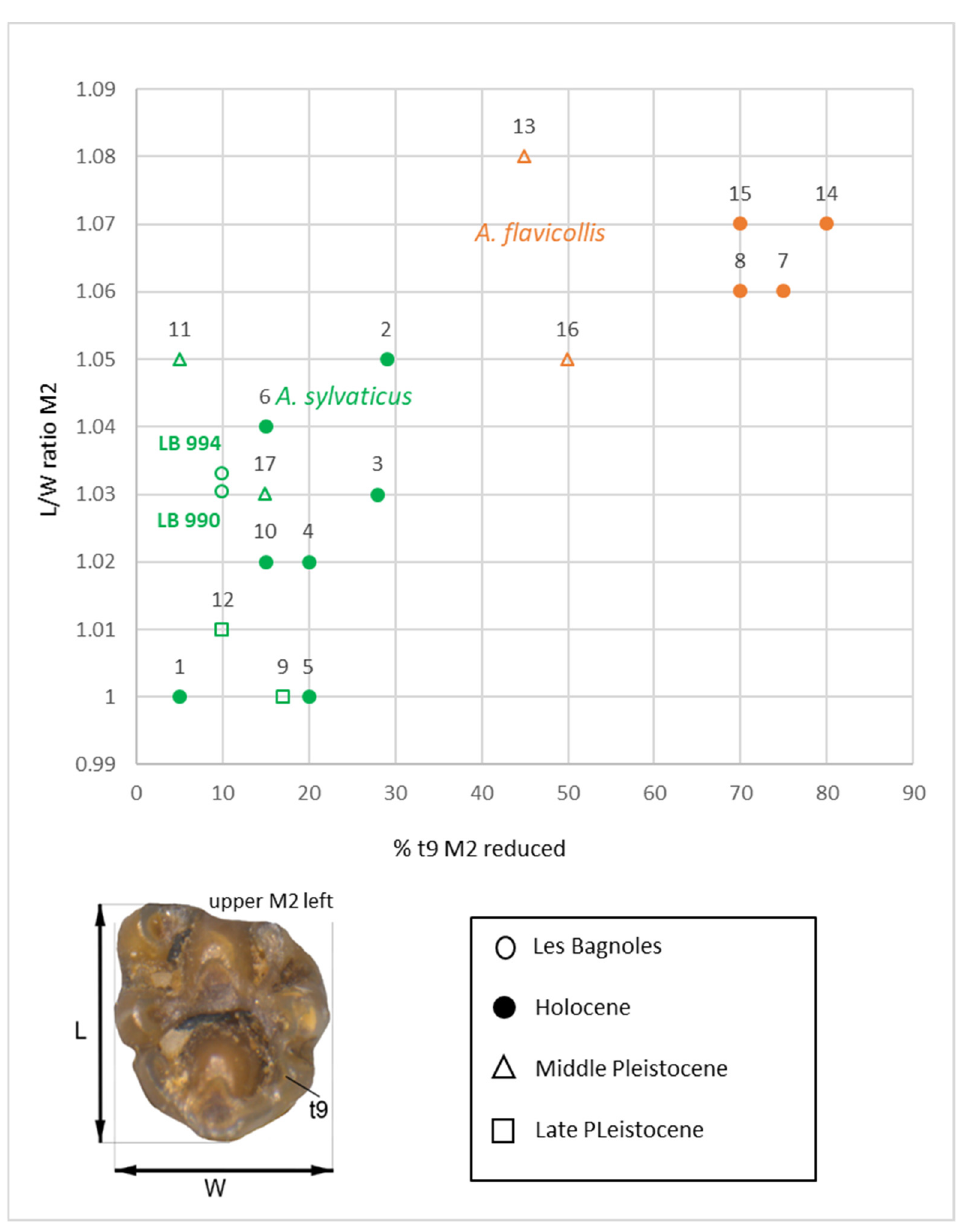
Figure 5. Apodemus finds: Scatterplot comparing L/W ratio of upper M2 and percentage of specimens with reduced t9 (tubercle 9); L 990: Les Bagnoles, well 990; L 994: Les Bagnoles, well 994; 1: Northern France, 2: Le Claux, 3: St. Mathieu de Tréviers, 4: Camargue, 5: Burgos, 6: Kirchdorf, 7: